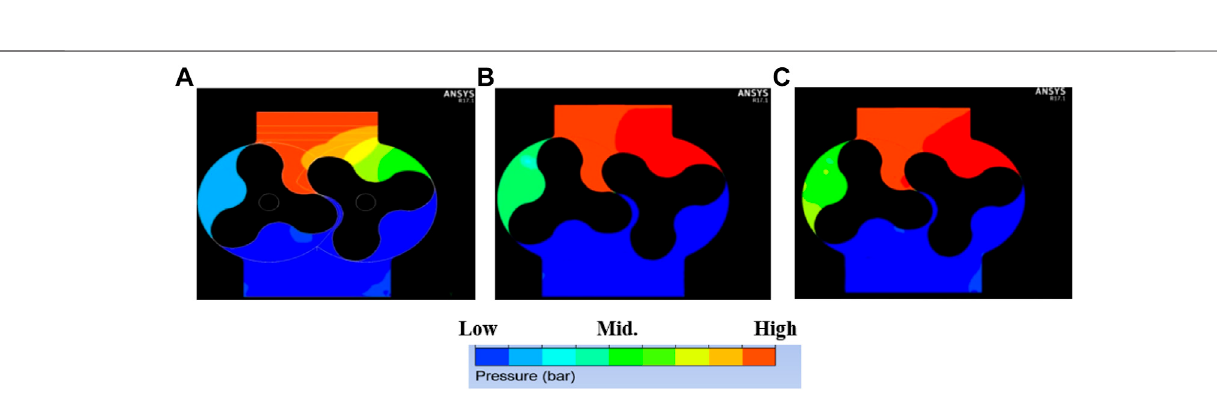
FIGURE 8 | Pressurization in the transfer volume before opening to the outlet port at 10,000 rpm and PR-1.3. (A) Without back fl ow port design. (B) One-side back fl ow port design. (C) Two-side back fl ow port design.